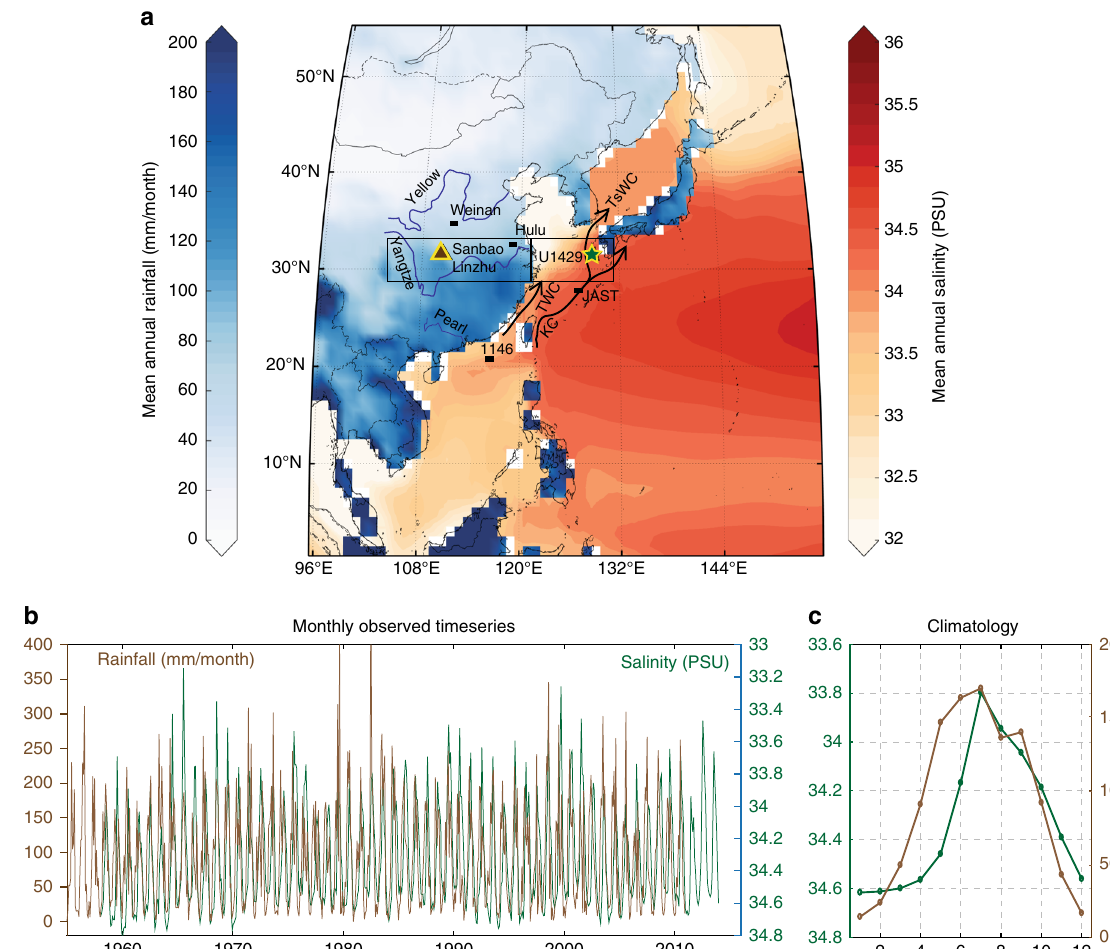
Fig. 1 Modern precipitation and salinity climatologies, rivers, and surface currents. a Locations of IODP Site U1429 and sediment trap site JAST-01 48 in the East China Sea. δ 2 H wax records precipitation isotopes from the Pearl River Valley 34 and the Loess Plateau 10 , deposited at IODP Site 1146 and Weinan, respectively. Boxes are area averages for CCSM3 model results. Kuroshio current (KC) and Tsushima warm current (TsWC) split south of U1429 90, 91 . Taiwan warm current (TWC) enters from the south. Sanbao, Linzhu, and Hulu caves are the locations from which the composite δ 18 O cave record was constructed 15 . b Modern rainfall in the Yangtze River Valley (brown) is highly correlated to salinity at East China Sea Site U1429 (green). At the annual cycle with the lag removed, r = 0.89 and the result is signi fi cant at p < 0.01. c Monthly climatology from b . Salinity from ORAS4 92 . Rainfall from GPCC 93